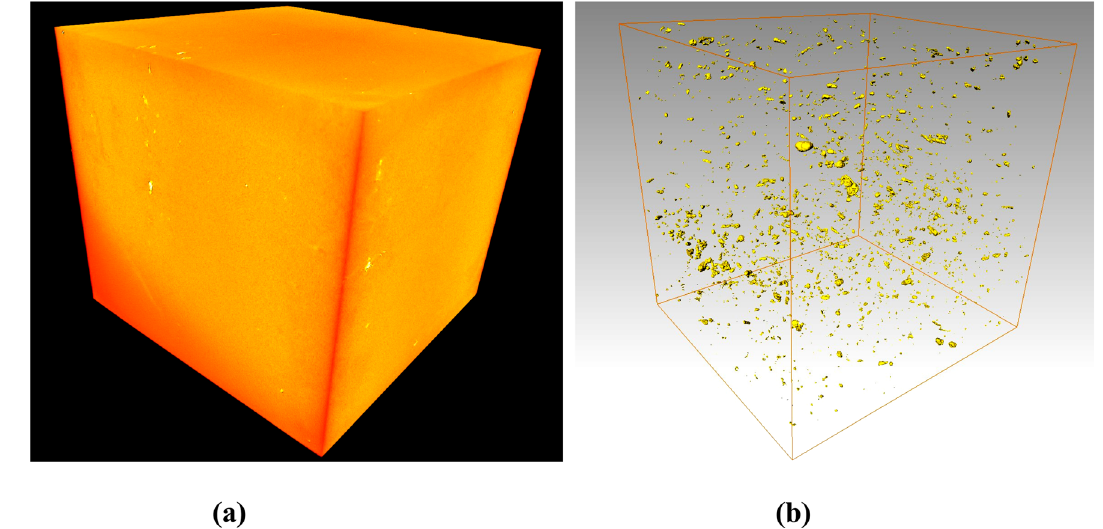
Figure 6. Three-dimensional visualization image of limestone sample under normal temperature: ( a ) Three- dimensional reconstruction rendering image; ( b ) Three-dimensional distribution map of high-density